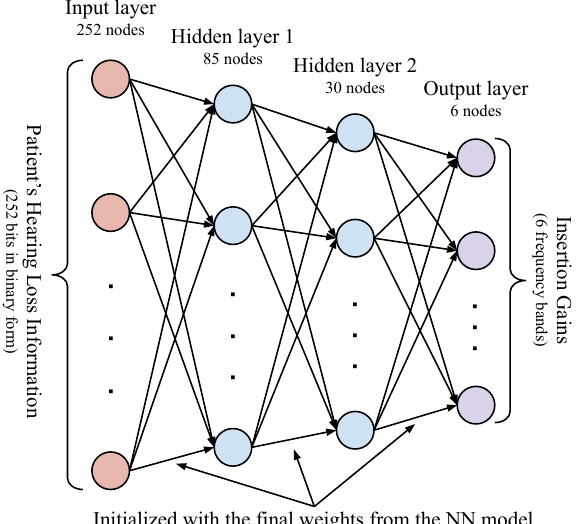
Figure 6. Parameter transfer learning